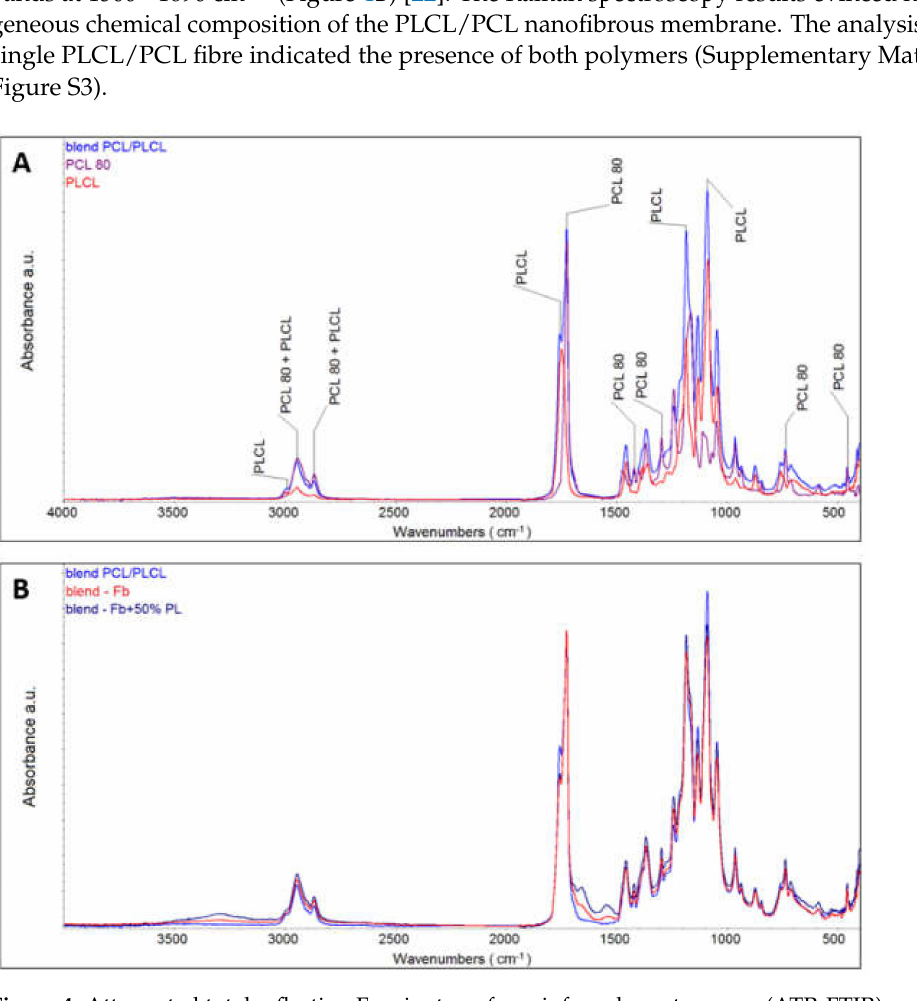
Figure 4. Attenuated total reflection Fourier transform infrared spectroscopy (ATR-FTIR) analysis of the PLCL/PCL and the spectra of pure PCL and pure PLCL ( A ), and lyophilized PLCL/PCL nanofibrous membranes coated with fibrin (blend-Fb) and fibrin with 50% of platelet lysate ( B